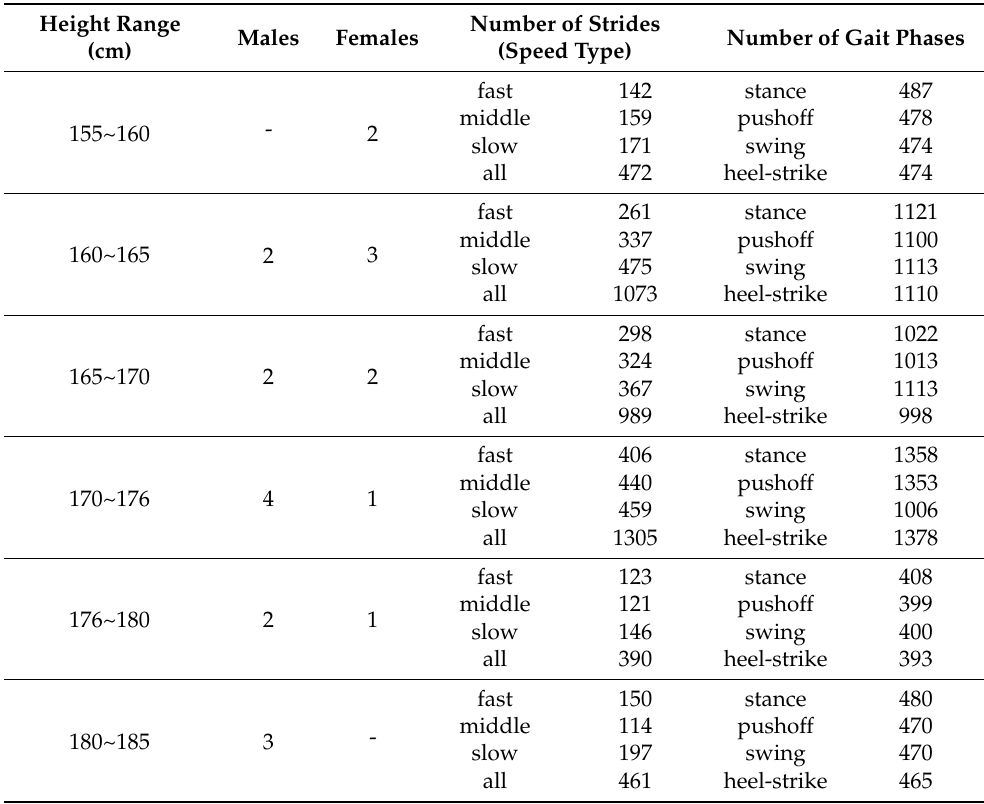
Table 2. A total of 22 healthy volunteers (13 males, 9 females, age 32.5 ± 7.5 years) participated in the study and were divided into different groups according to gender and height